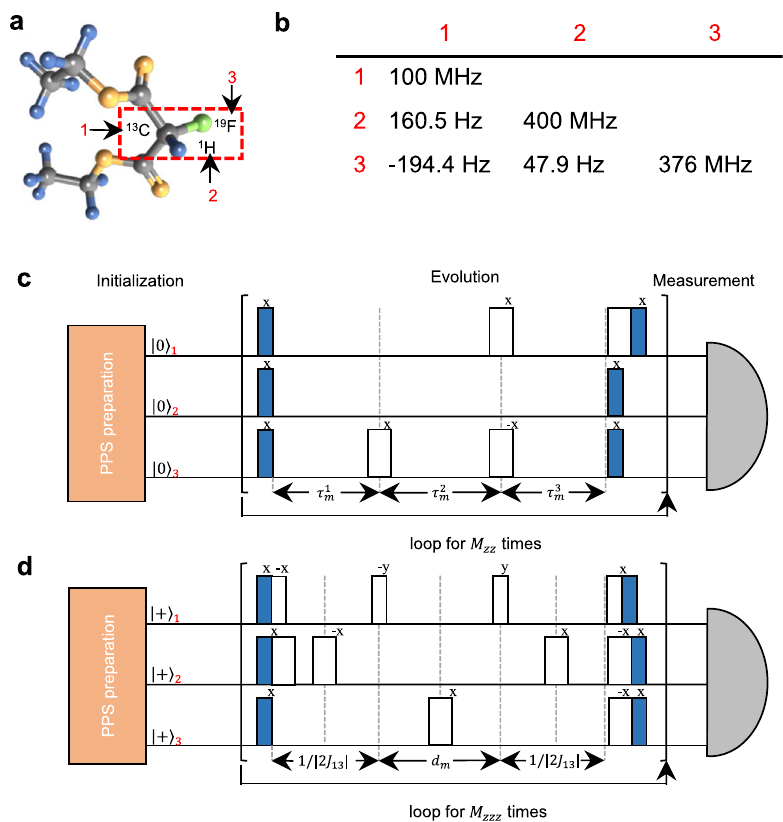
Fig. 4 Experimental setup. a Molecular structure of Diethyl fl uoromalonate. The three nuclear spins 13 C, 1 H and 19 F adopted in the experiment are labeled. The corresponding qubit index is also marked in red for each nuclear spin with a black arrow. b Parameters of the natural Hamiltonian of the three-spin system are shown in this table. The diagonal terms are the values of the chemical shift and the off- diagonal terms represent the scalar coupling between the different nuclei. c and d shows the schematic diagram explaining the experimental procedure for H zz and H zzz , respectively. In the initialization part, we prepare the system from a pseudopure state (PPS) into the designed Hamiltonian ’ s ground state. In the evolution part, a discrete refocusing scheme is used to perform two Hamiltonians. Combining with Trotter expansion, we can perform adiabatic evolution under any interaction. The wide and narrow un fi lled pulses represent π and π /2 pulses, respectively while the rotation axes are labeled above each pulse. The fi lled pulses represent a rotation of ω x τ /2, where τ means the length of each Trotter slice. The measurement part is carried out using quantum state